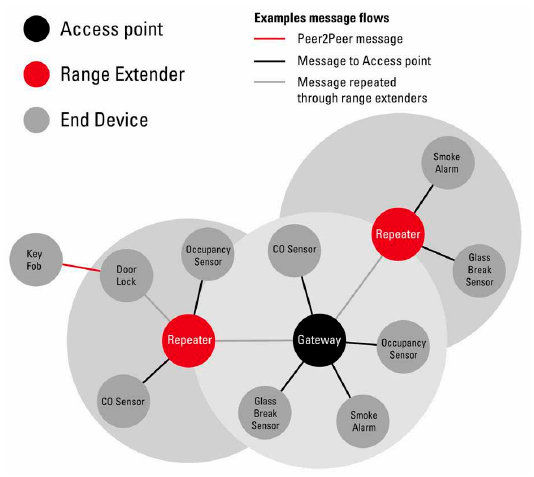
Figure 9. SimpliciTI wireless protocol [69].